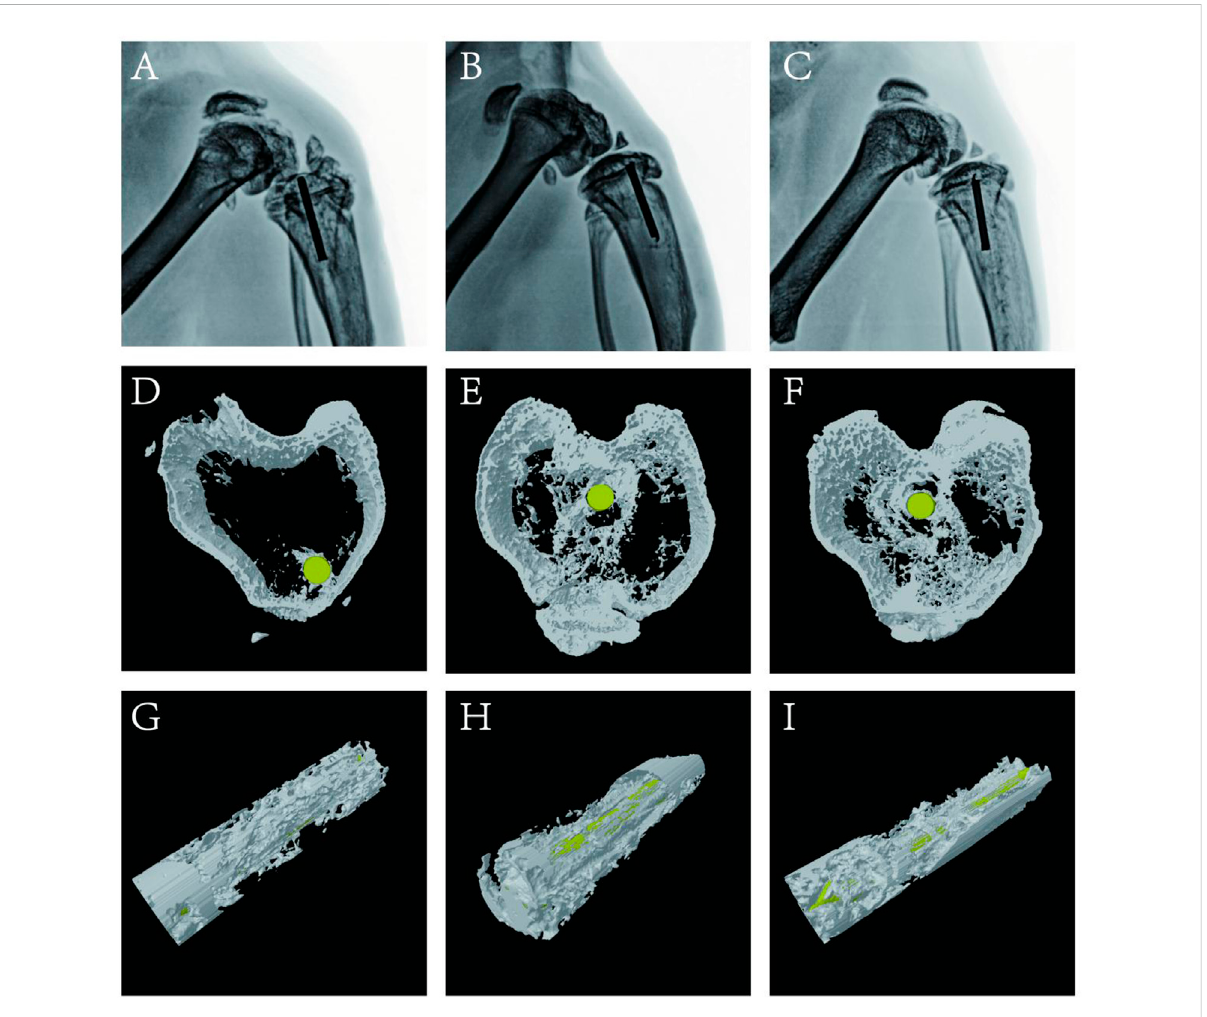
FIGURE 9 X-ray examination: (A – C) unmodi fi ed, (MMT/HA-RFP) 10 , and sham groups, respectively. Trabecular distribution: (D – F) unmodi fi ed, (MMT/HA- RFP) 10 , and sham groups, respectively. New bone formation surrounding implants: (G – I) unmodi fi ed, (MMT/HA-RFP) 10 , and sham groups,